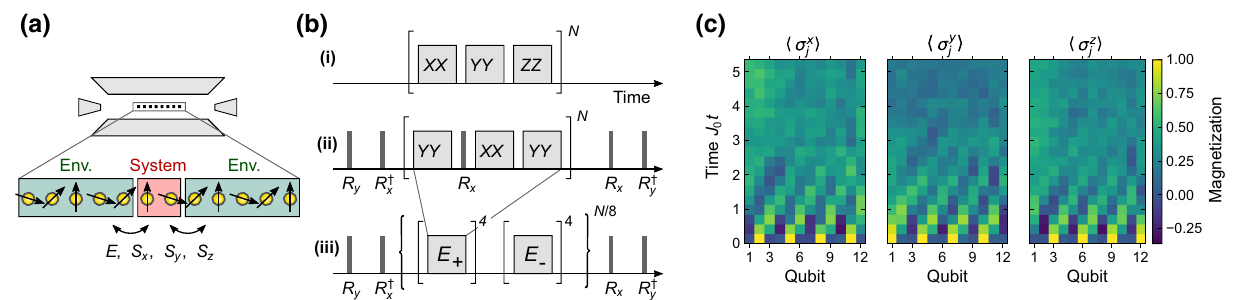
FIG. 1. The experimental setup and protocol. (a) A linear ion crystal of N ≤ 21 qubits is trapped in a linear Paul trap. A small system exchanges charges (local instances of quantities that are conserved globally) with the surrounding environment: the energy, E , and all the components of angular momentum. (b) We Trotter approximate the Heisenberg evolution by evolving the state under each of the three terms of the Hamiltonian [Eq. (3)] consecutively, in short time steps. We experimentally realize two terms directly and generate the third term using resonant π/ 2 pulses ( R x and R y ). This pulse sequence further protects the state against dephasing noise (ii). The Trotter sequence contains building blocks E ± . Alternating between them reduces pulse-length errors (iii). For further details, see Appendix A. (c) The observed evolution of the 12-qubit initial state, | y + , x + , z +(cid:3) ⊗ 4 , under the